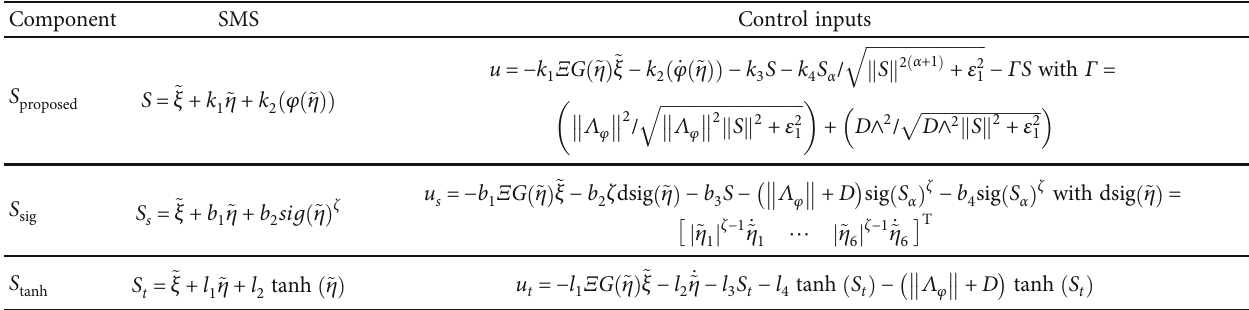
Table 4: Three di ff erent kinds of SMC schemes.